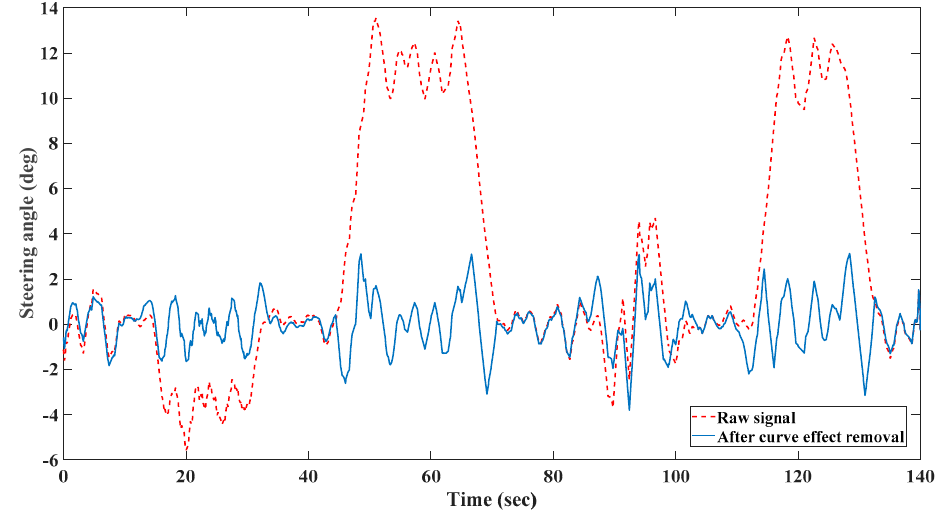
Figure 2. Road curve effect removal.